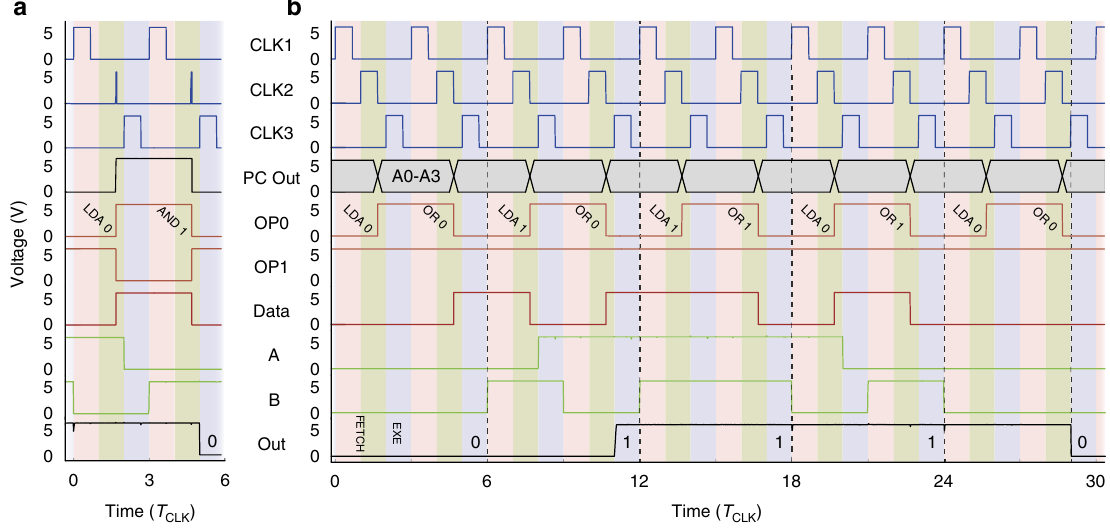
Figure 4 | Device operation. ( a ) Waveforms measured on the chip when running the sample program, explained above. The CLK1, CLK2 and CKL3 signals were generated externally. Each instruction requires three CLK cycles, where 1/ T CLK is the CLK frequency. CLK2 pulses were made sufficiently short to trigger the level-sensitive input of the PC; this could be avoided by using a more complex master-slave design (Supplementary Fig. 9). A0 is the address supplied by the PC. OP0, OP1 and D0 denote the signals from the memory, where the former two are the instruction and the latter is the data. A and B are the input signals to the ALU, and OUT is the output of the device. T CLK ¼ 500ms. ( b ) Results for a series of other calculations. In order to run the longer program, a 4-bit PC was implemented externally. The meaning of the curves is the same as in a , apart from A0 which schematically depicts here the 4-bit address signal (A0 – A3). Again, the device is able to deliver the expected logic values, shown as numbers at the